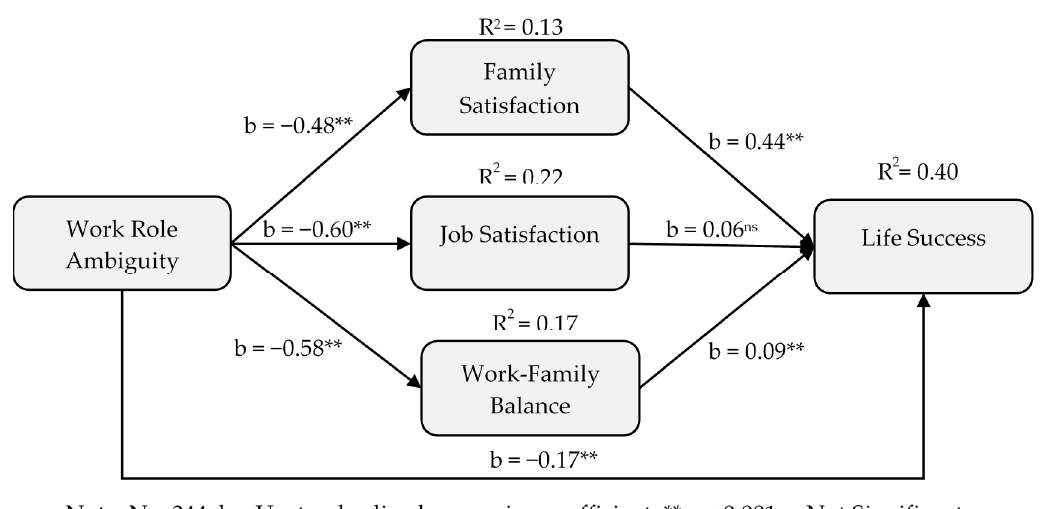
Figure 5. Mediational model on work role ambiguity and life success.